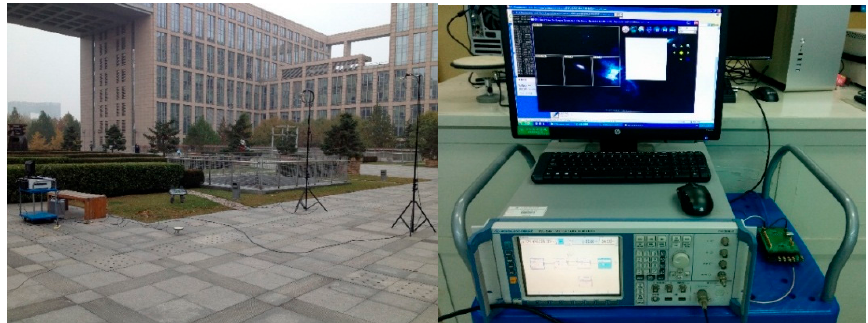
Figure 7. The hardware setup for the experiments.